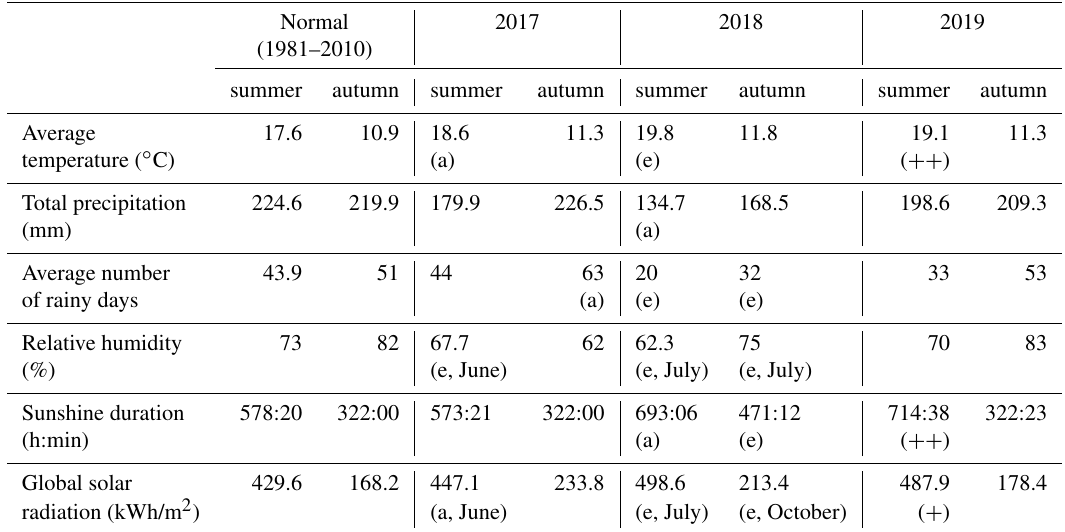
Table 1. Overview of the meteorological conditions during the summer and autumn of 2017, 2018 and 2019. All data are measured by the meteorological station of the Royal Meteorological Institute (KMI) in Ukkel, Belgium (KMI, 2018a, b, 2017b, a, 2019a, b). The degree of abnormality of the values is represented by two labels: a for abnormal values (with a recurrence time of 6 years) or e for exceptional values (with a recurrence time of 30 years). In the case only 1 month had abnormal values, this label is followed by the name of that particular month. Since 2019, the KMI has used a new system to show the degree of abnormality: values that are among the five highest values since 1981 are marked by ( + ), while values within the three highest values are marked by ( ++ )